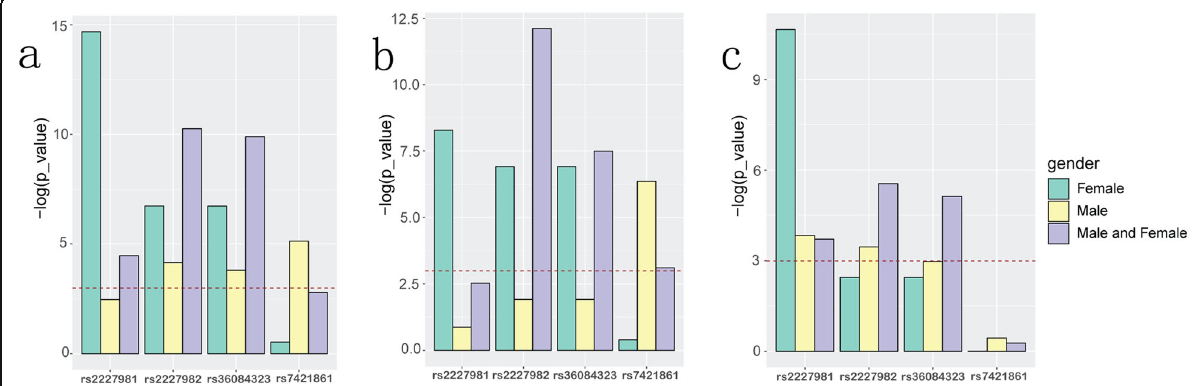
Fig. 2 Association of PD-1 SNPs with lung adenocarcinoma stages in different models. a allele model; b dominant model; c recessive model. The dashed red lines indicate the significance threshold ( p _value = 0.05) using chi-square